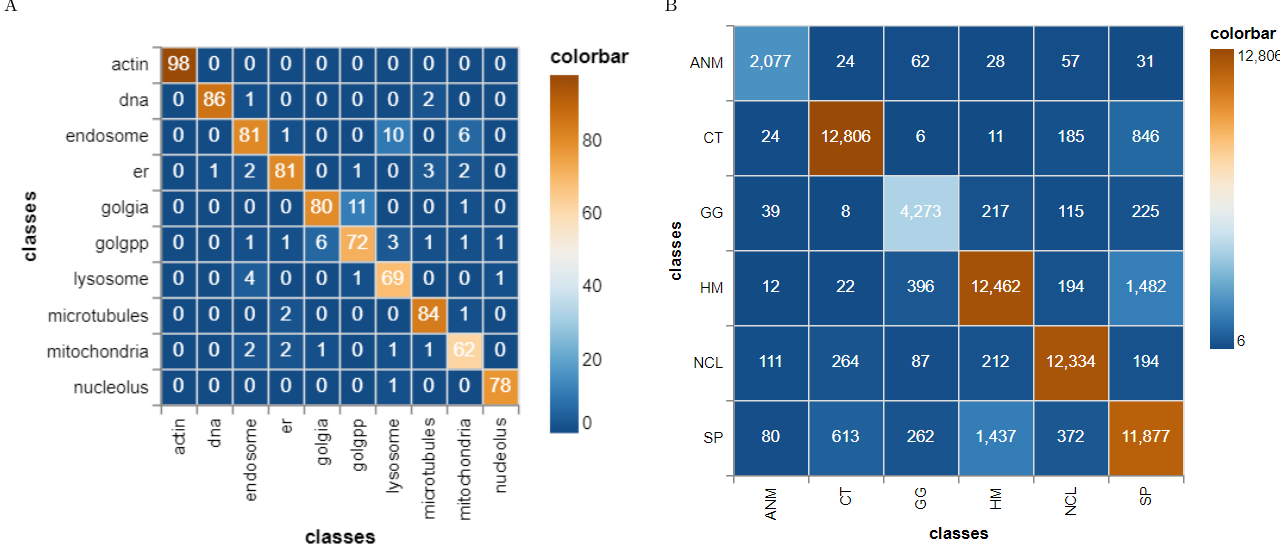
Figure 10. Confusion matrix of 10 fold cross validation for HeLa ( A ) and HEp2 ( B ) using SVM, regional and scale space features and feature selection. ( A ) HeLa data set, class annotations are the same as in Figure 5; ( B ) HEp2 data set, class annotations are the same as in Figure